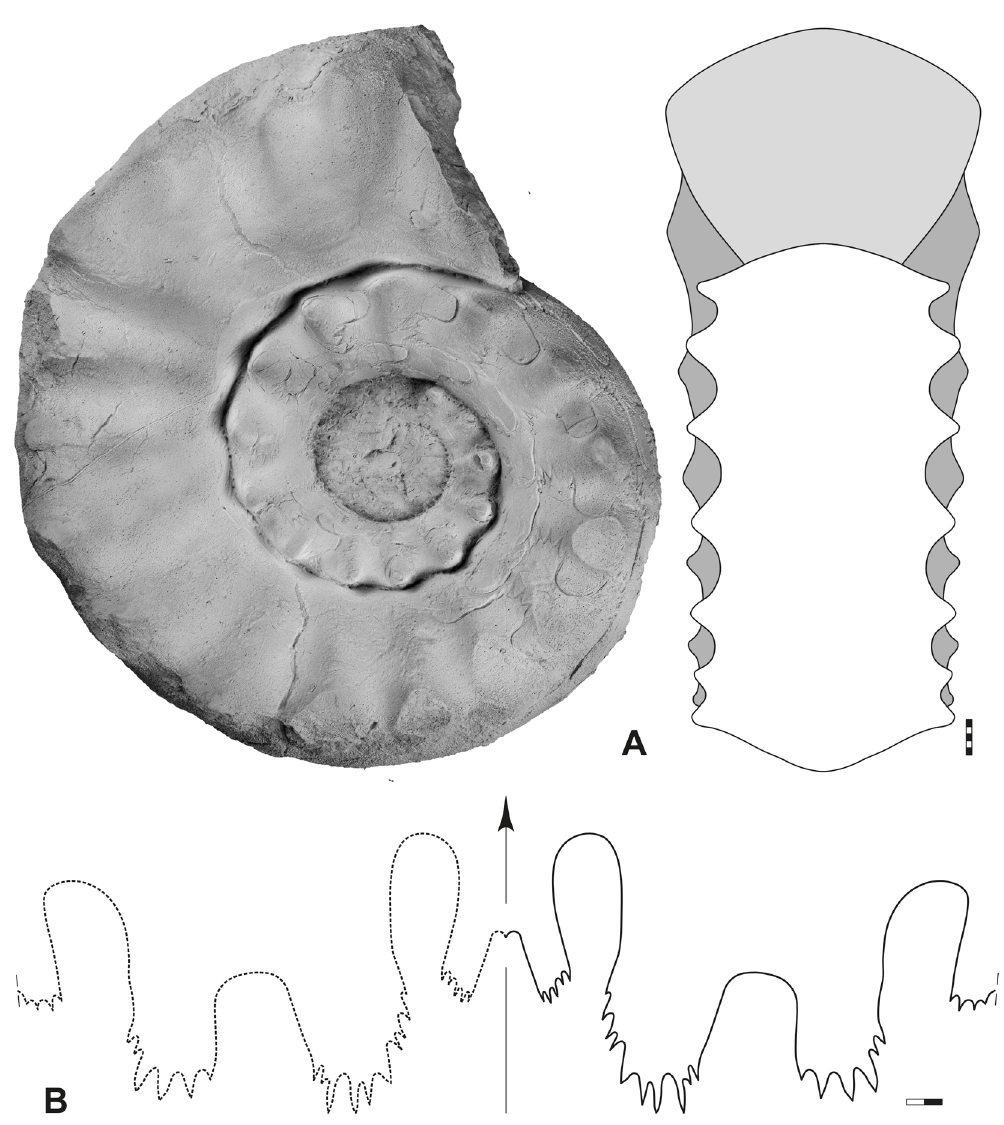
Fig. 45. Esfahanites armatus Korn & Hairapetian gen. et sp. nov., holotype MB.C.29964, section E, float. A . Lateral and dorsal view. B . Suture line, at 58.0 mm dm, 35.0 mm ww, 22.0 mm wh. Abbreviations: see Material and methods. Scale bar units =